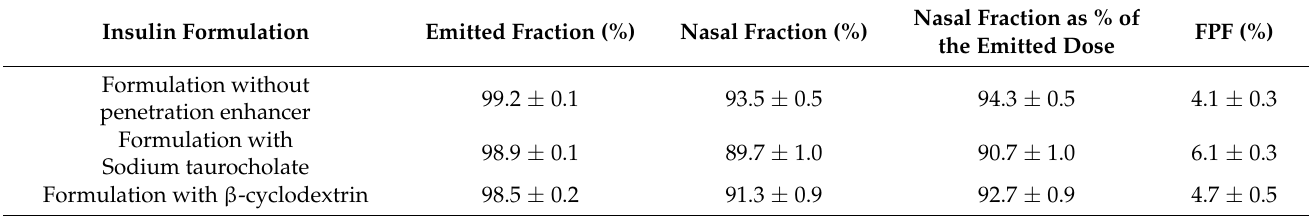
Figure 1. SEM images of insulin loaded SFD particles without penetration enhancer ( A ), with sodium taurocholate ( B ), or with β-cyclodextrin ( C ). Table 2. NGI data for the insulin